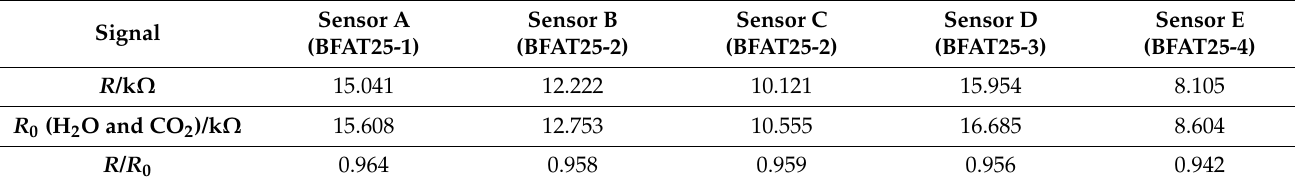
Table 3. Effect of H 2 O and CO 2 on the electrical resistance R of the BFAT25